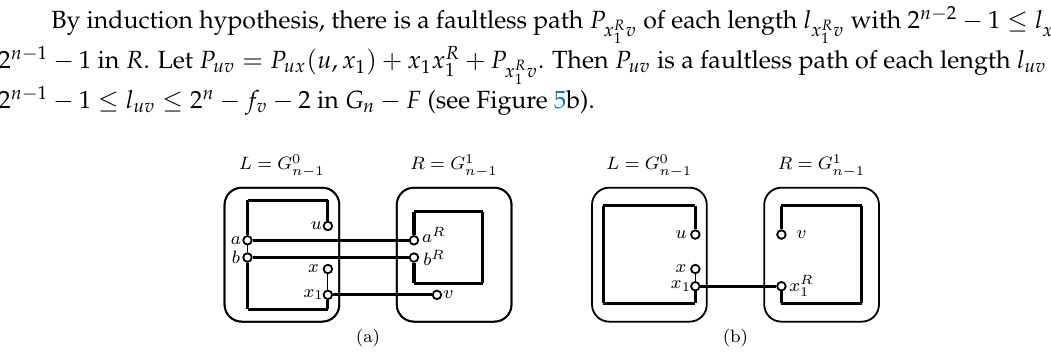
Figure 5. ( a ) Illustration of proof of Case 2.1.2.1; ( b ) Illustration of proof of Case 2.1.2.2.